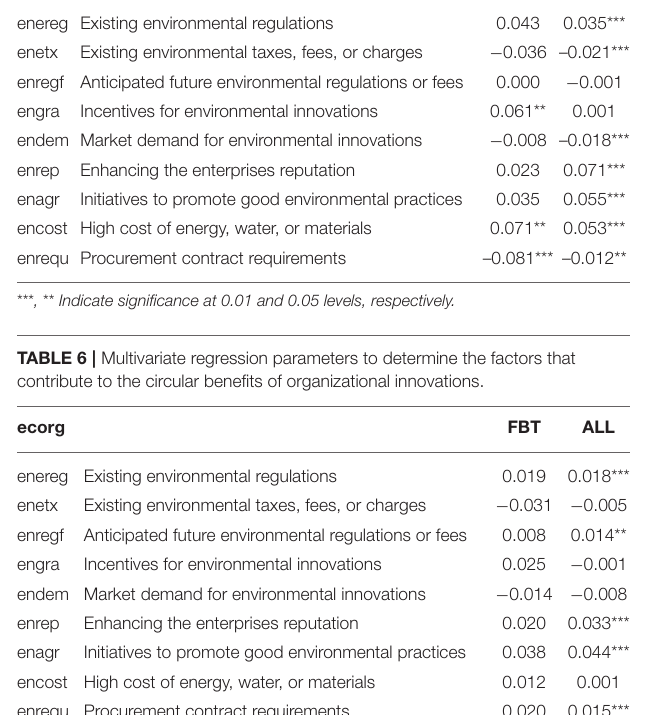
TABLE 5 | Multivariate regression parameters to determine the factors that contribute to the circular benefits of process innovations. ecoprc